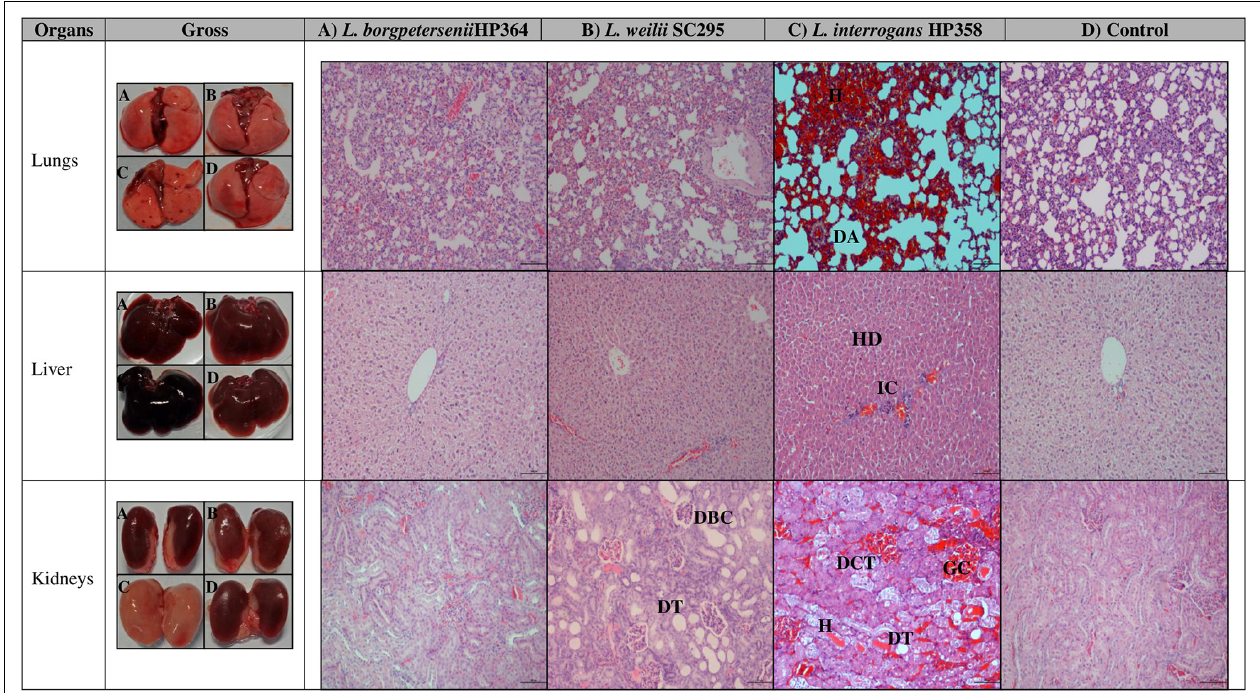
FIGURE 3 | Gross and microscopic observation of organs in infected and control hamsters. H, hemorrhage; DA, dilated alveoli; HD, hepatic disarray; IC, infiltration on inflammatory cells; DBC, dilated Bowman capsule; DT, dilated tubule; DCT, disarrangement of cells in tubules; DT, dilated tubule; GC, glomerulus congestion. Magnification × 100, bar: 100 µ m.